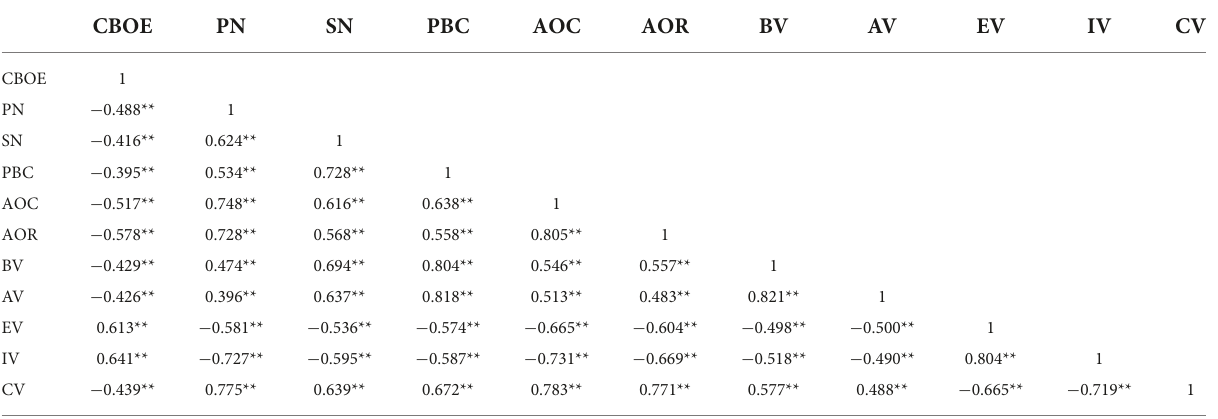
TABLE 4 Correlation matrix of the theoretical framework